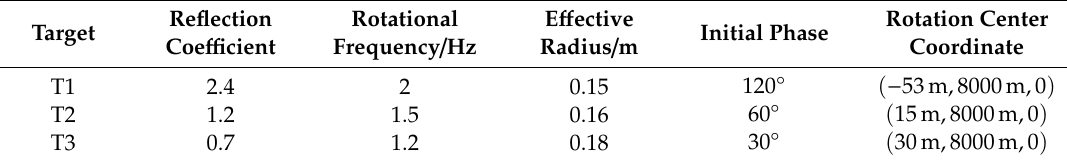
Table 1. Target parameter setting.